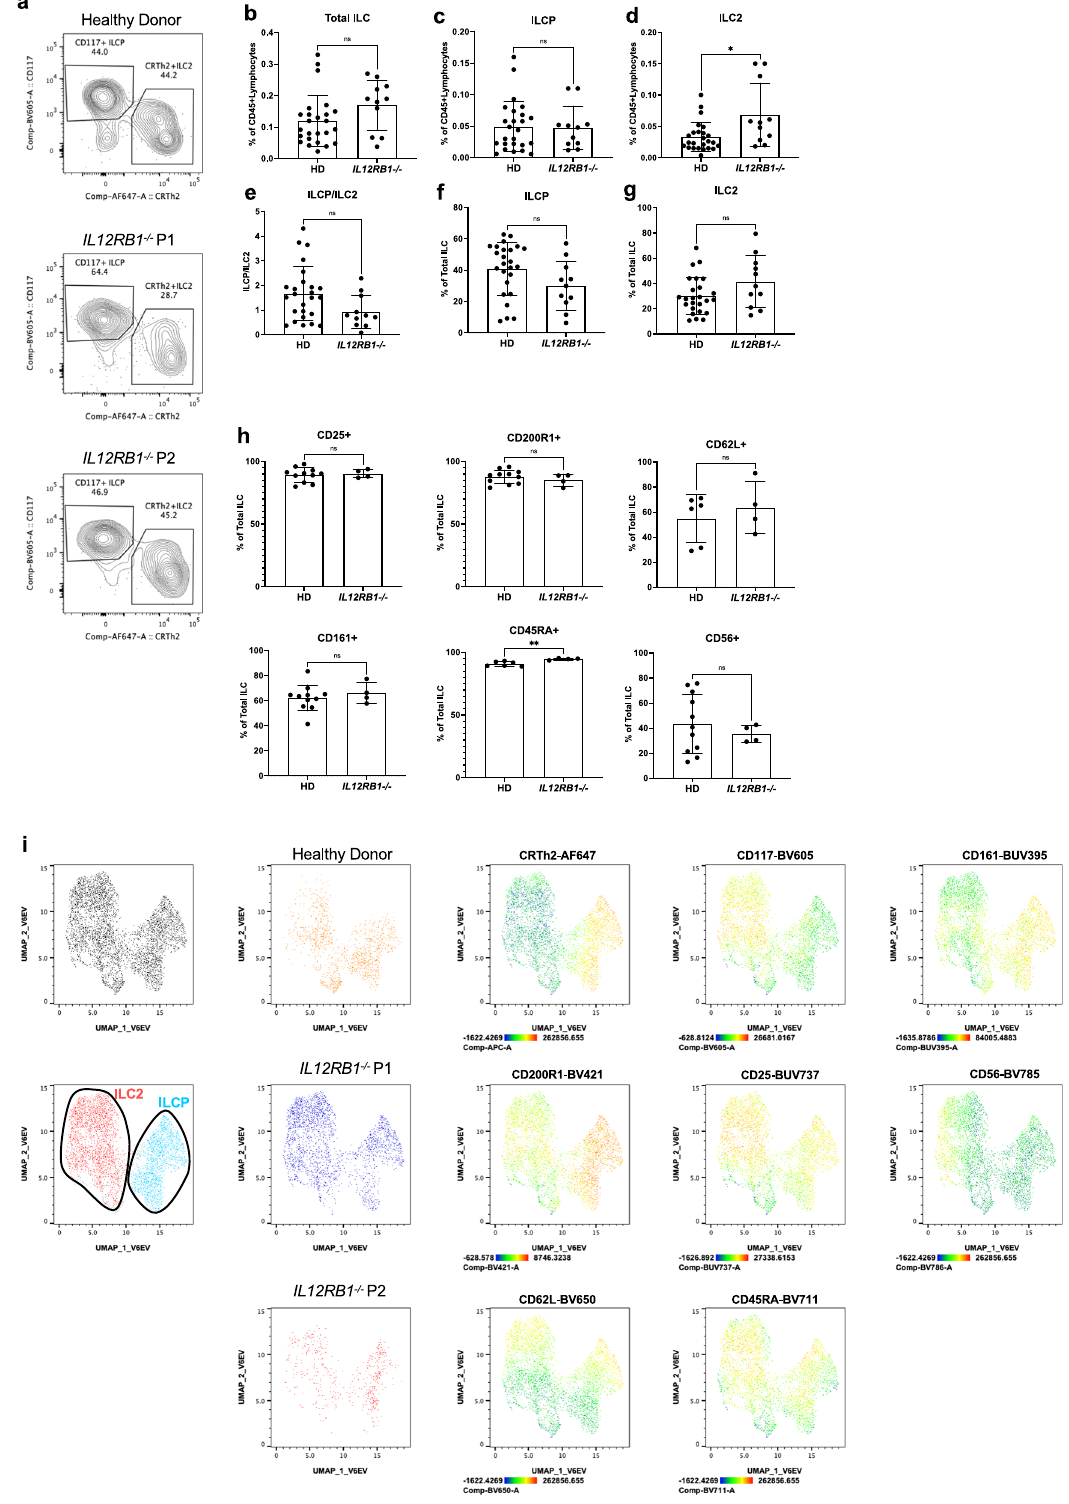
Fig. 6 | Human ILC differentiation in IL12RB1 − / − patients. a Flow cytometric analysisofILCsfromahealthydonorandtwo IL12RB1 − / − patients(gatingstrategyin Supplementary Fig. 1). Relative frequencies of b total ILC ( c ) ILCP ( d ) and ILC2 in CD45+live lymphocytes. e RatioofILCPto ILC2. Relative frequenciesof f ILCPand g ILC2 in total ILCs. h Expression of markers CD25, CD200R1, CD62L, CD161, CD45RA and CD56 on ILCP of healthy donors and IL12RB1 − / − patients. b – g Comparisons done using two-tailed Mann – Whitney test. ns=not signi fi cant,